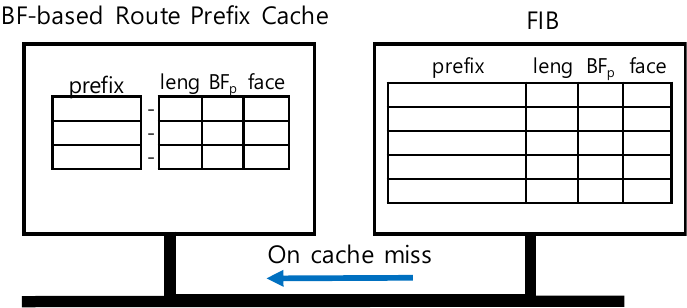
Figure 6. The organization of overall name lookup.